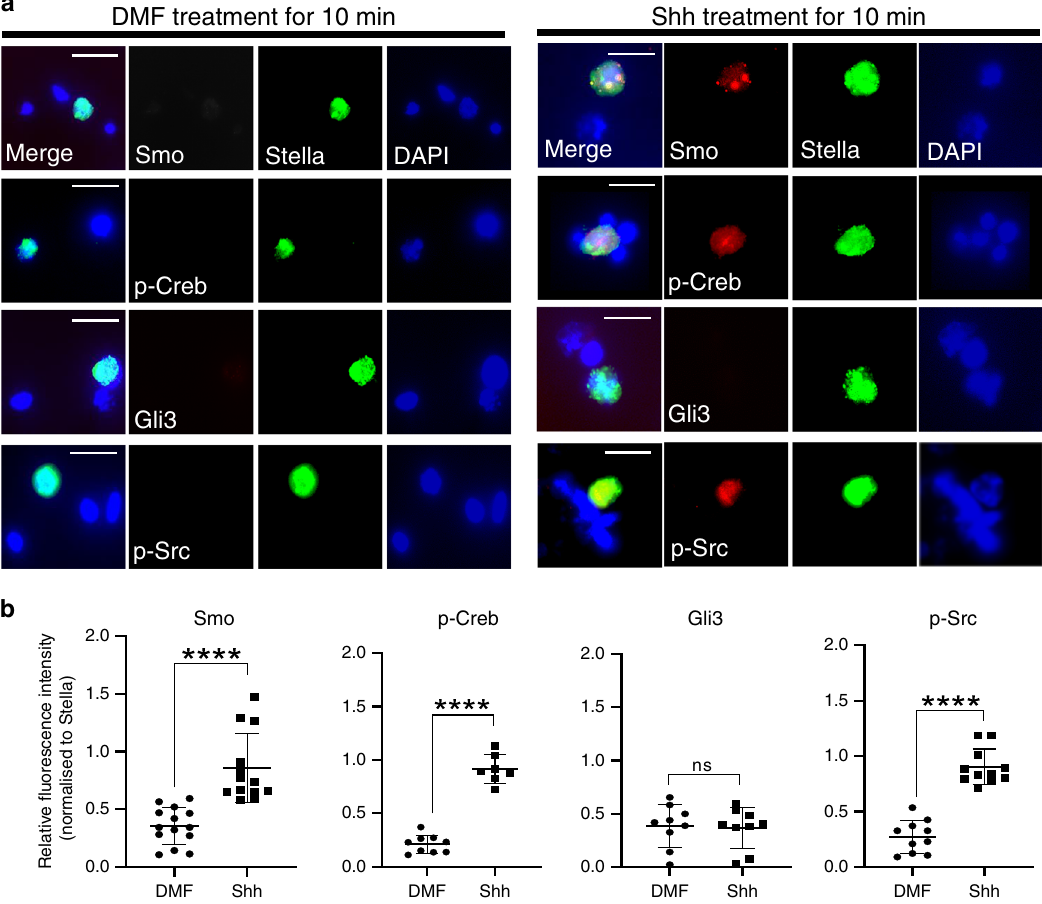
Fig. 9 PGCs show rapid non-canonical Hh signalling responses. a Immuno fl uorescence of Smo, p-Creb, Gli3 and p-Src, co-stained with germ cell marker Stella in GR primary culture cells with or without Shh treatment for 10 min. Representative images from at least three biologically independent experiments are shown. Scale bar, 10 µ m. b The relative fl uorescence intensity values of Smo, p-Creb, Gli3 and p-Src, normalised to the signal intensity of Stella observed in PGCs were compared with or without Shh treatment. Unpaired t -test with Welch ’ s correction indicates a signi fi cant increase in Smo (DMF ( n = 14), Shh ( n = 13), **** P < 0.0001), p-Creb (DMF ( n = 9), Shh ( n = 7), **** P < 0.0001) and p-Src (DMF ( n = 10), Shh ( n = 11), **** P < 0.0001) but no signi fi cant change in Gli3 (DMF ( n = 9), Shh ( n = 9), P = 0.8542). Error bars represent SD. Unpaired t -test with Welch ’ s correction. Source data are provided as a Source Data fi